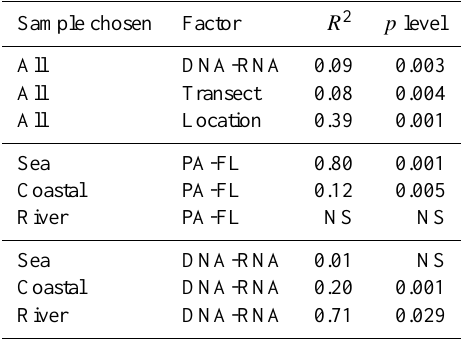
Table 2. Results of ANOSIM analyses to test significant differences in community structure between DNA (indicative of all present OTUs) and RNA (indicative of active OTUs), between transects (western and eastern) and between locations (river, coast and sea). From those groups showing significant differences in community structure, we then tested the different groups separately for differ- ences between particle-attached (PA) and free-living (FL) commu- nity structure and between total and active community structure. R 2 = explained variance. p level = level of significance. NS =